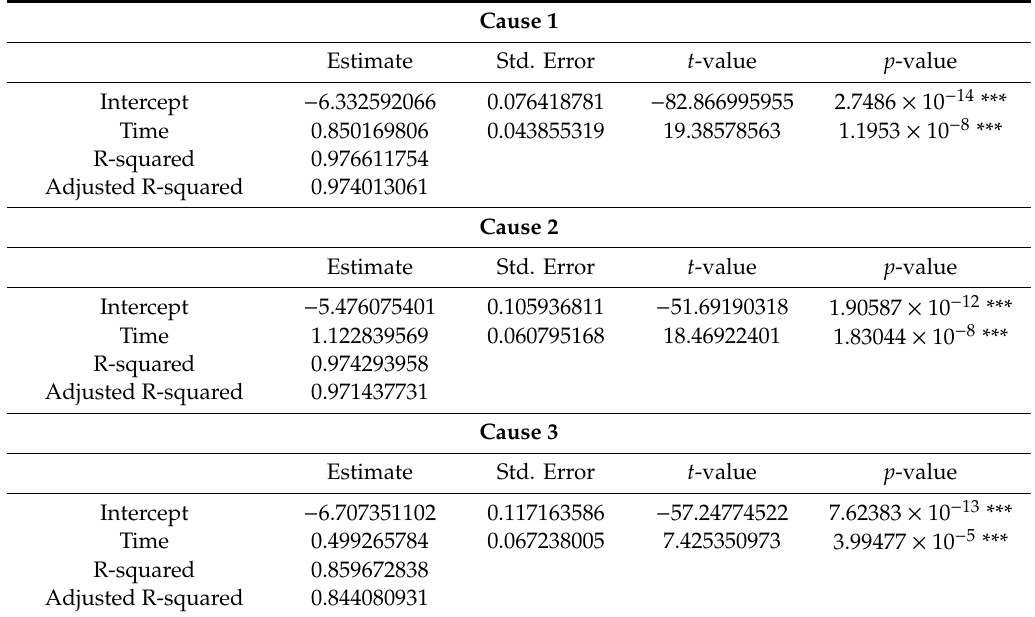
Table 6. Significance of coe ffi cients derived from Equation (17).